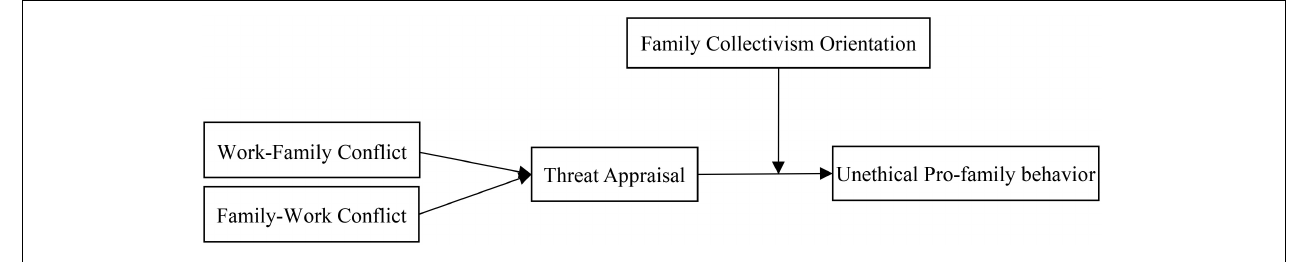
FIGURE 1 | Hypothesized conceptual model of the